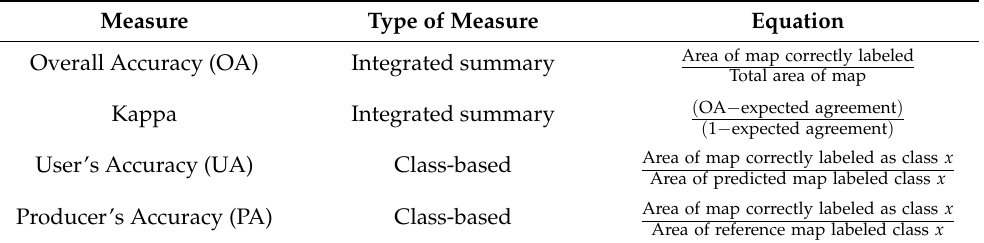
Table 2. Multiclass metrics derived from the confusion